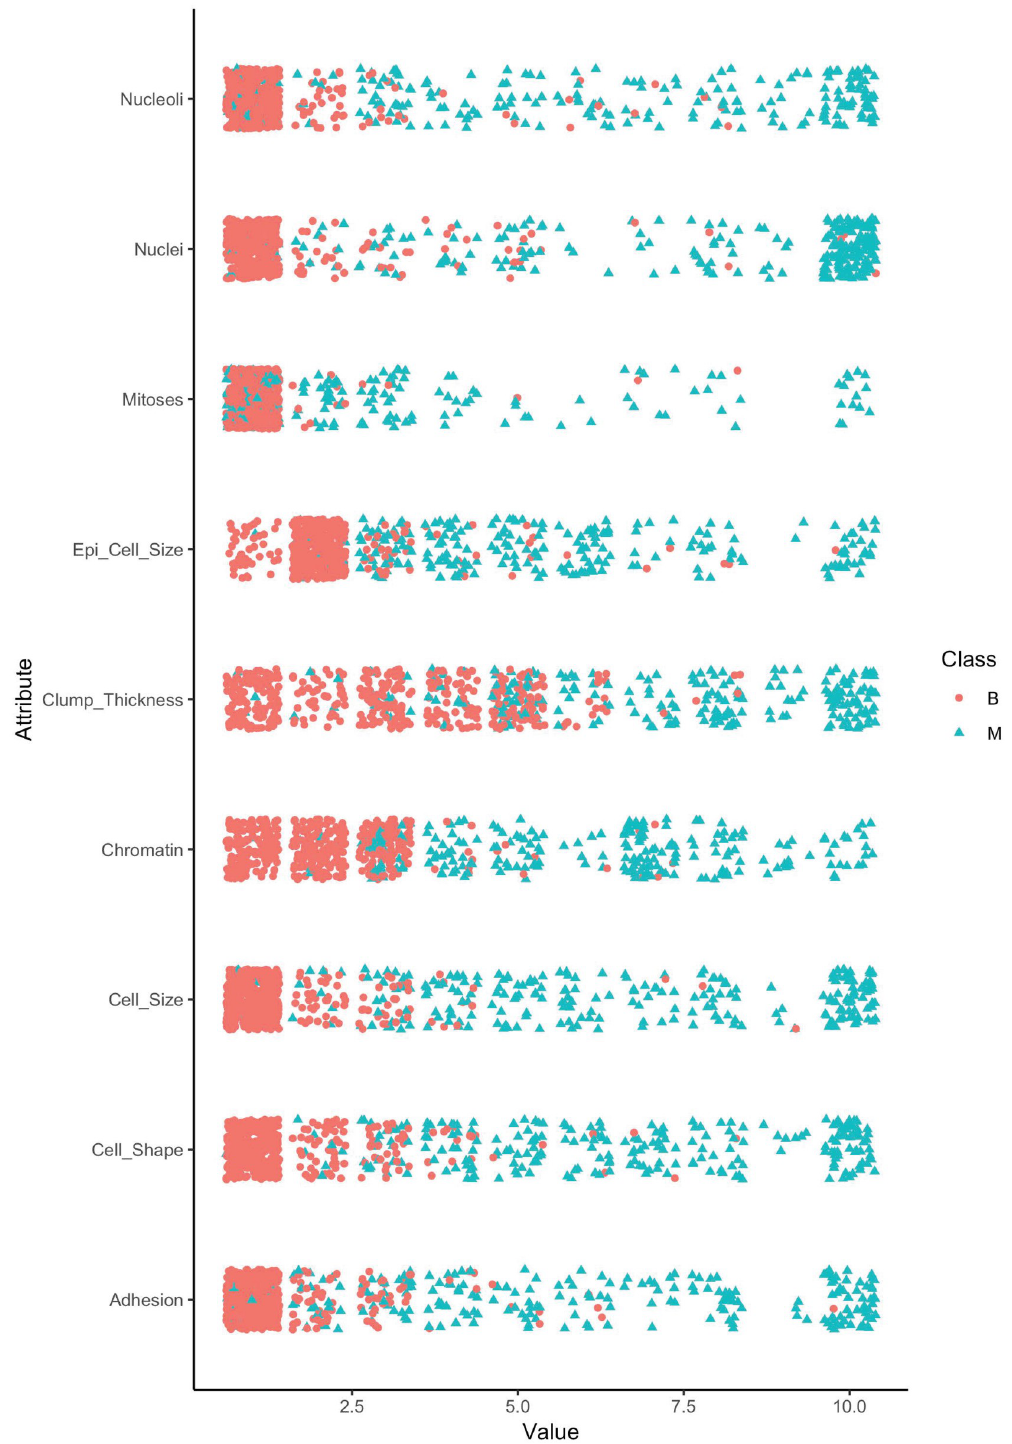
Fig 5. Distribution of class attribute in the predictors.